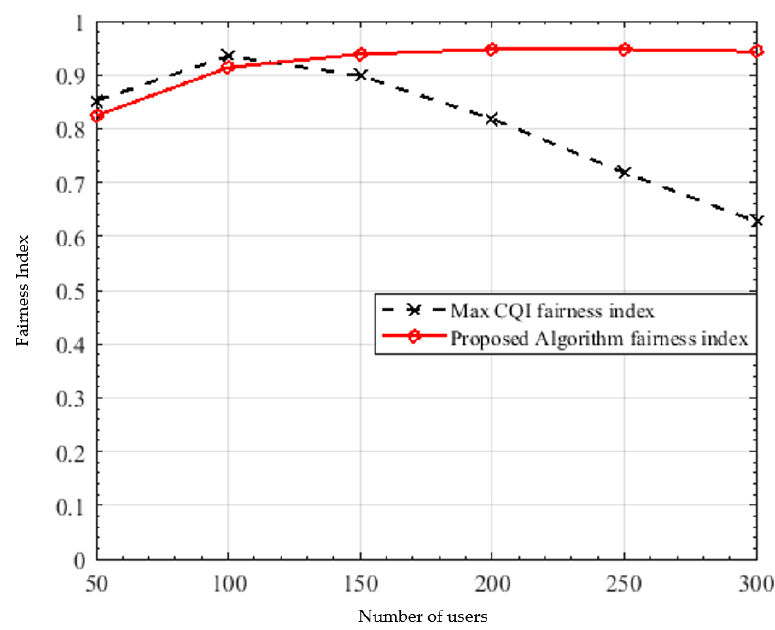
Figure 6. Fairness index versus number of users.